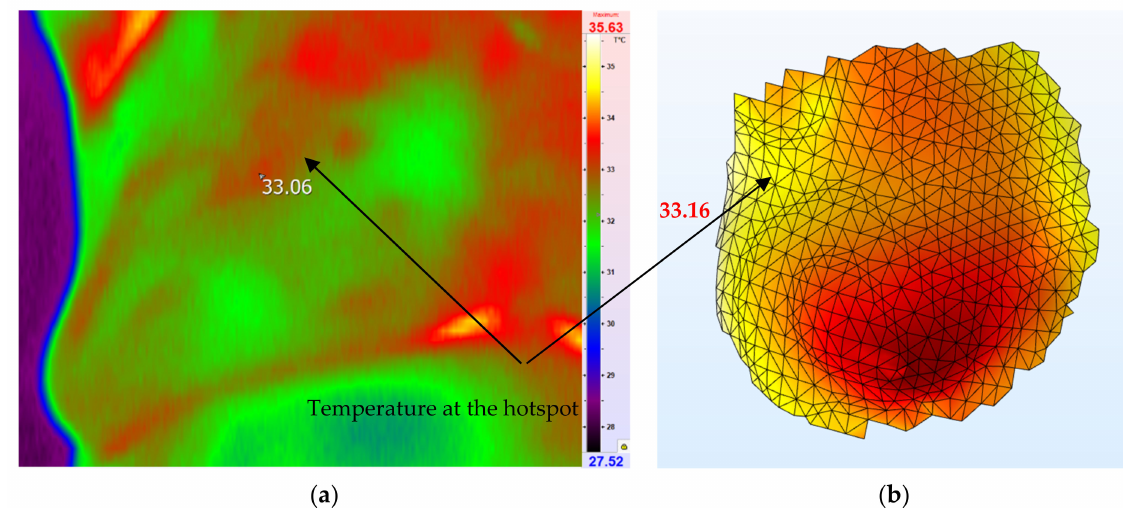
Figure 14. Comparison of measured ( a ) and computed ( b ) temperature distributions (patient No. 5) with a percentage error of 0.30% in hotspot temperature prediction.